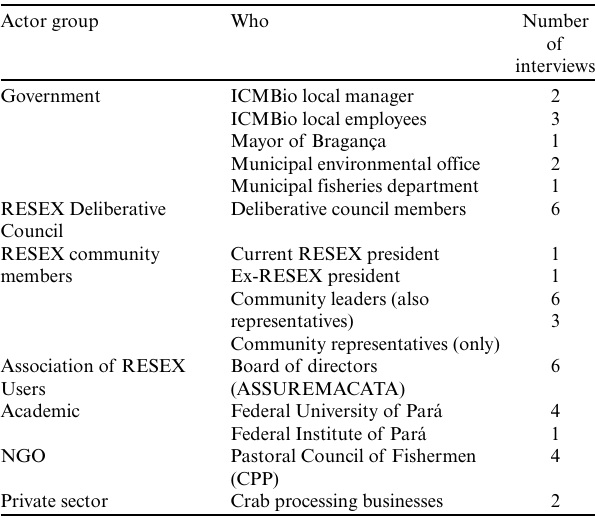
Table 1 . List of interviewees by stakeholder group, the specific actor within that group, and the number of interviews. ICMbio = Chico Mendes Institute for Biodiversity Conservation; RESEX = marine extractive